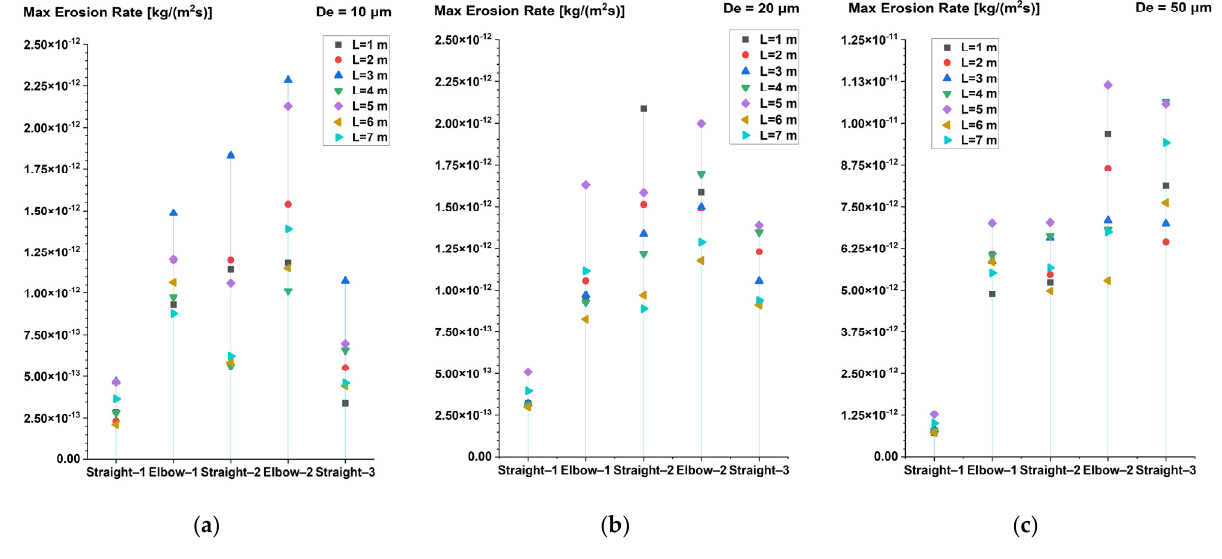
Figure 15. The max erosion rate at all computation domains with the different Straight-2 lengths and different average diameters: ( a ) The average particle size is 10 μ m; ( b ) the average particle size is 20 μ m; ( c ) the average particle size is 50 μ m.